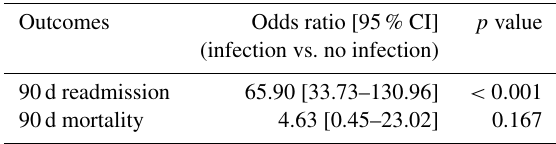
Multiple logistic regression. Health conditions are as classified in the CIHI Population Risk Grouper data. “Cardiac conditions” include acute myocardial infarction or arrest, arrhythmia, coronary artery disease, cardiac valve disease, malformation of cardiovascular system, and heart failure. “Chronic renal conditions” include chronic kidney disease/failure. Table 5. Adjusted secondary